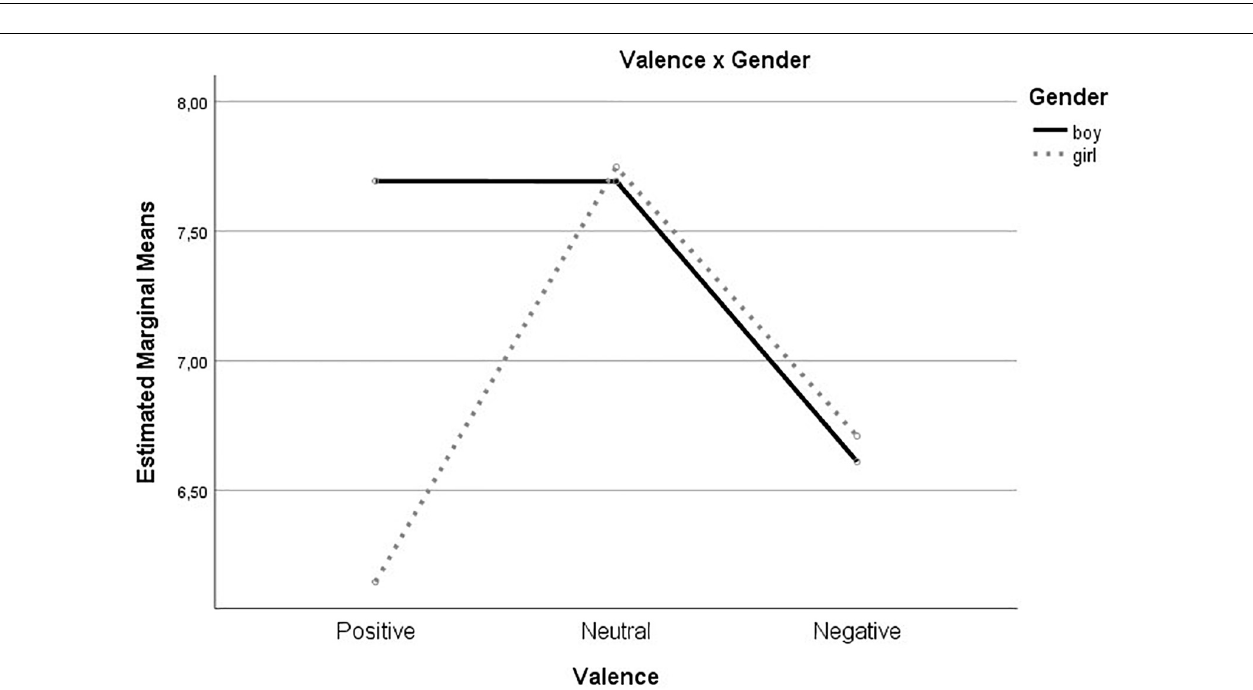
FIGURE 5 | Valence × Gender interaction. Note: estimated marginal means for the valence (Positive vs Neutral vs Negative) × Gender interaction on the number of correctly localized target stimuli are displayed on the y -axis.